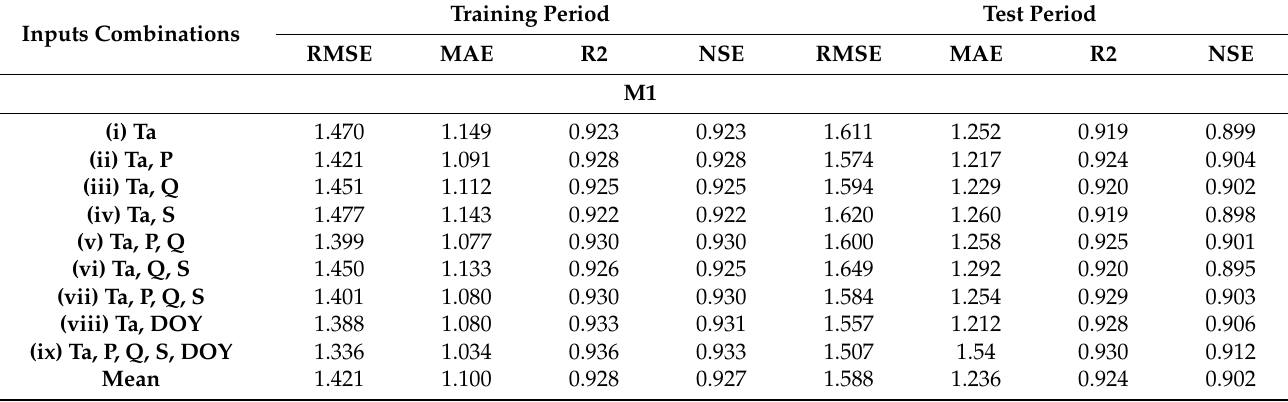
Table 5. Training and test statistics of the models for water temperature prediction—CNN-RSA. Inputs